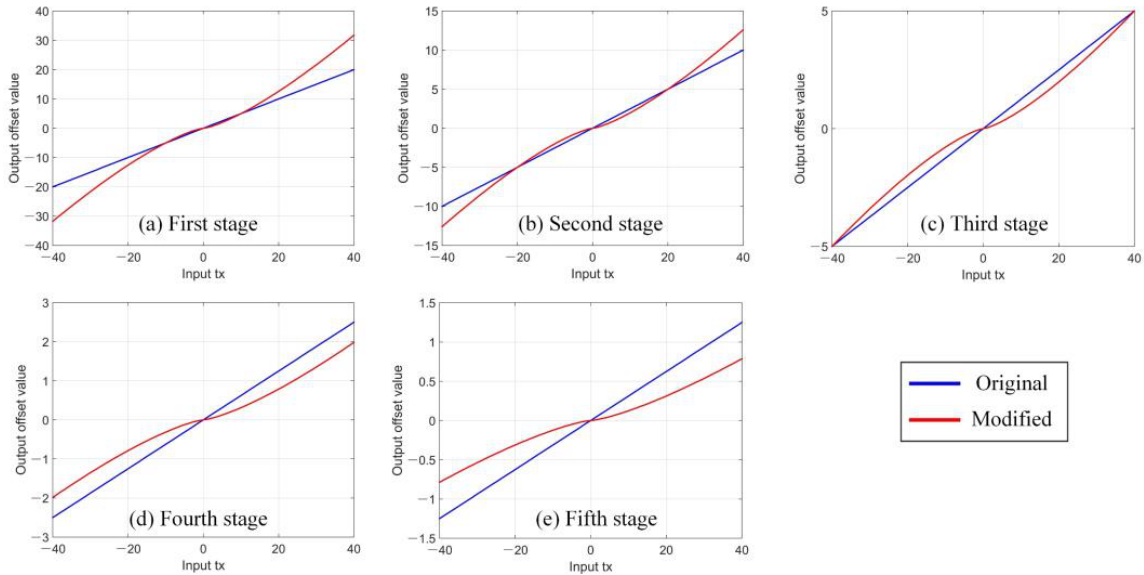
Figure 4. Input offsets t x vs. bounding box output offset g x − p x plotted for the original and